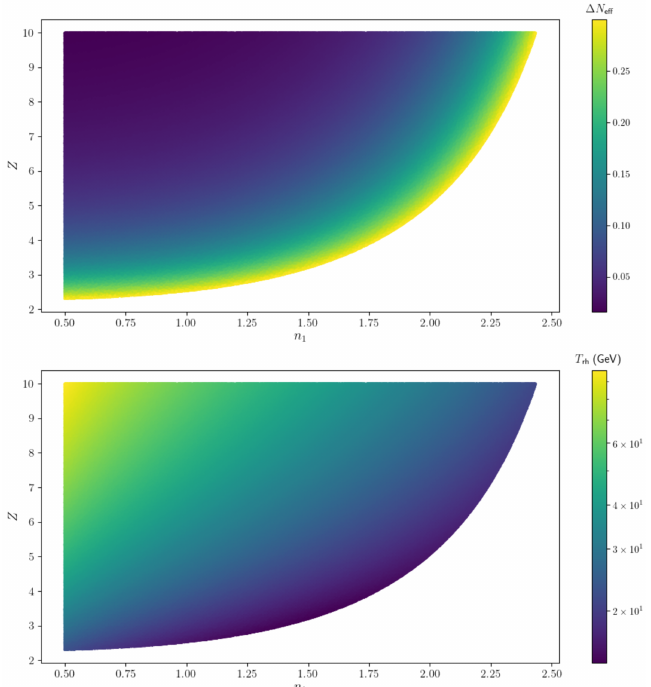
Figure 2 . The upper plot shows allowed ∆ N eff for the case k 1 = 1 and k 2 = 0 in the ultralocal limit. The lower plot again shows the corresponding reheat temperature in GeV for the benchmark mass in table 1. This plot also describes the case k